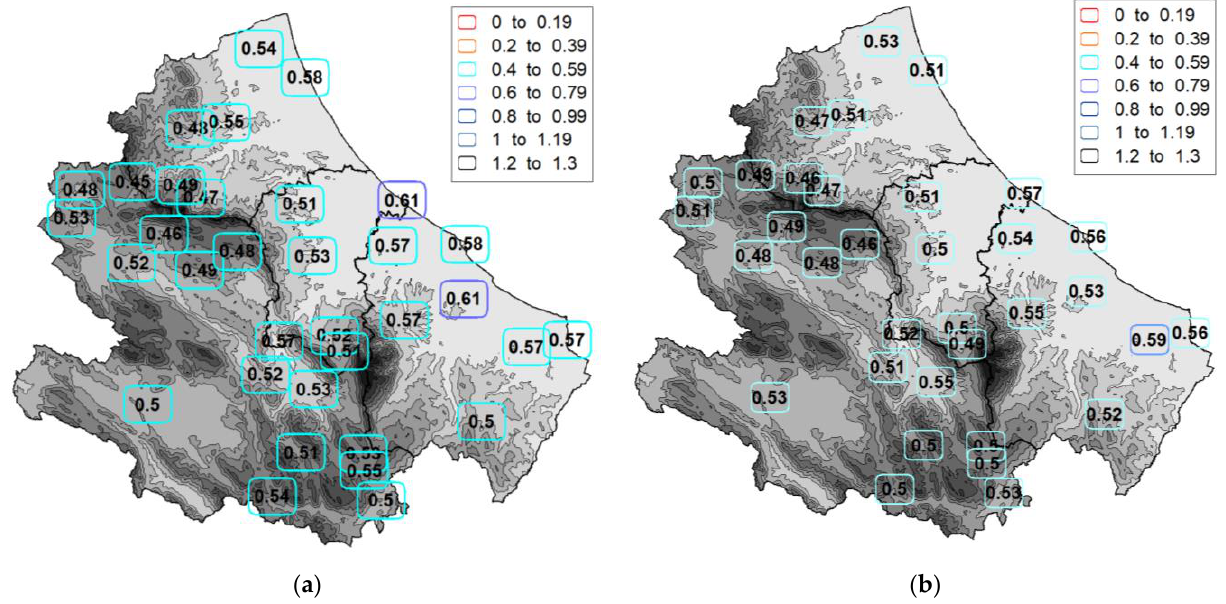
Figure 6. Spatial distribution of median SI: ( a ) point data; ( b ) grid E-OBS data.